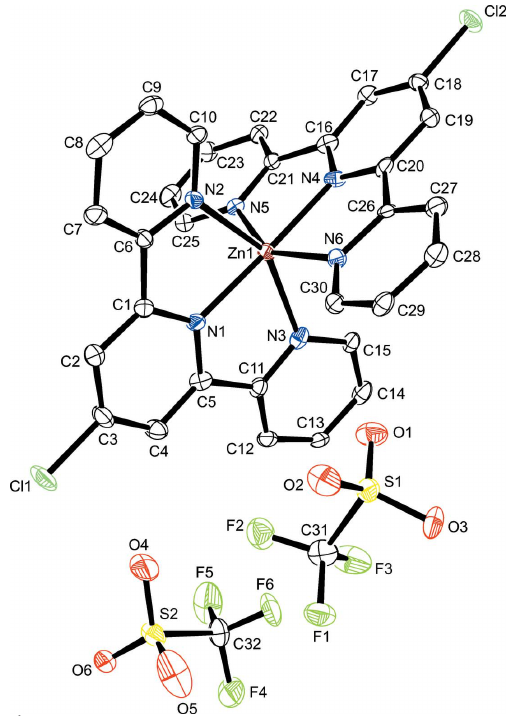
Figure 1 The molecular structure of the title compound with displacement ellipsoids drawn at the 50% probability level; H atoms are omitted for